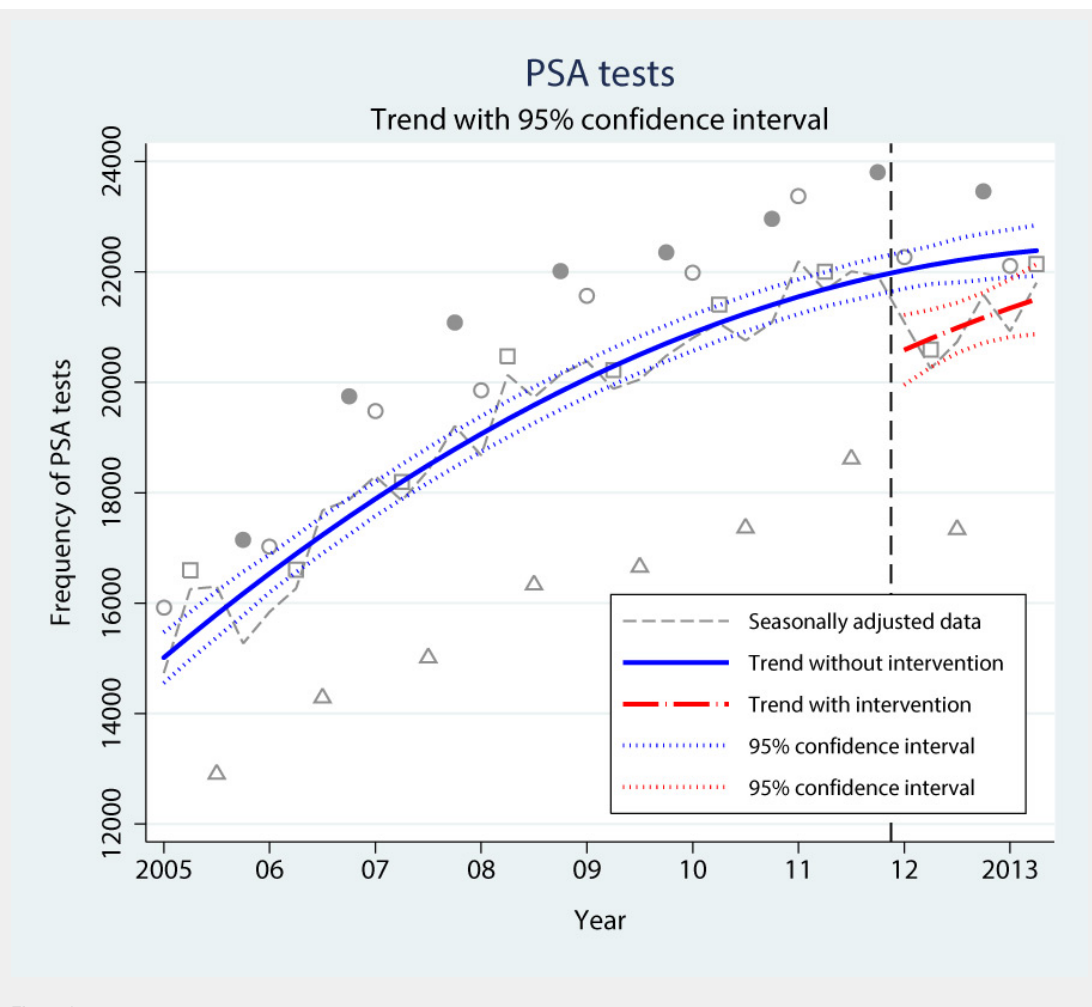
Figure 2 Prostate specific antigen (PSA) tests over time (2005–2013). Each data point represents the number of PSA tests over 3 months in Helsana Insurance (○ JAN-MAR; □ APR-JUN; ∆ JUL-SEP; ● OCT-DEC). The dashed line is corrected for seasonal effects. Vertical dashed line: Time point of SMB report released in 2011. Blue solid trend line: Trend (95% CI) without Swiss Medical board (SMB) recommendations up to 2013. Red solid trend line: Trend (95% CI) after release of SMB recommendations in